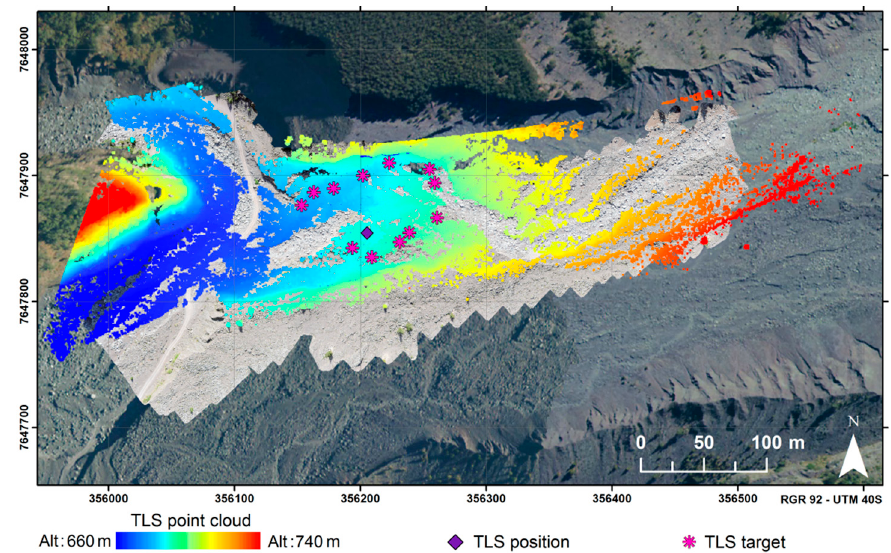
Figure 4. Terrestrial Laser Scanner (TLS) point cloud colored by height. The point cloud is superimposed on the orthophotograph computed with PhotoScan software chain. (Background is an extract from the BD Ortho ® —IGN © , 2008).